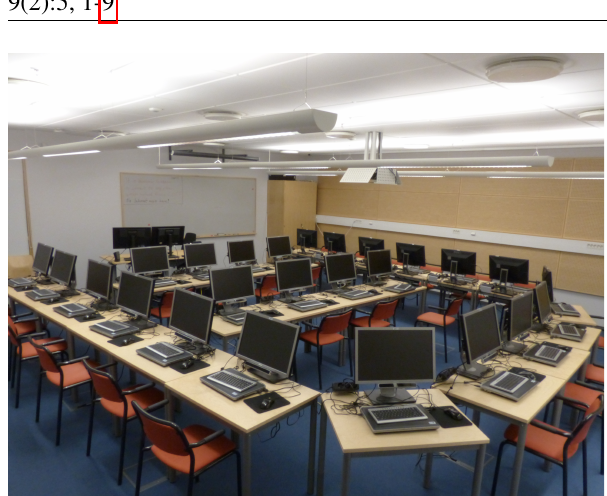
Figure 1 . The Digital Classroom, Lund University, equipped with 25 RED-m eye trackers from SensoMotoric Instru- ments.